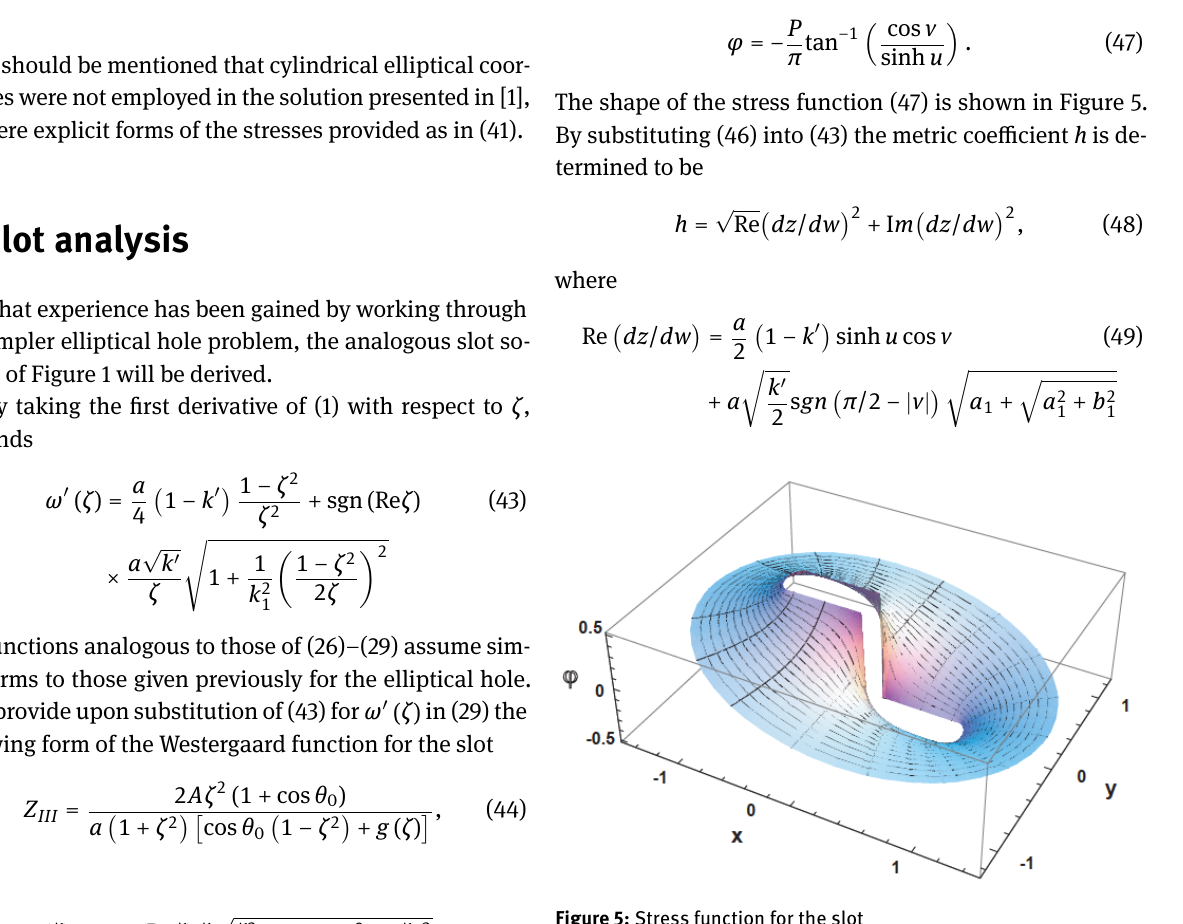
Figure 5: Stress function for the